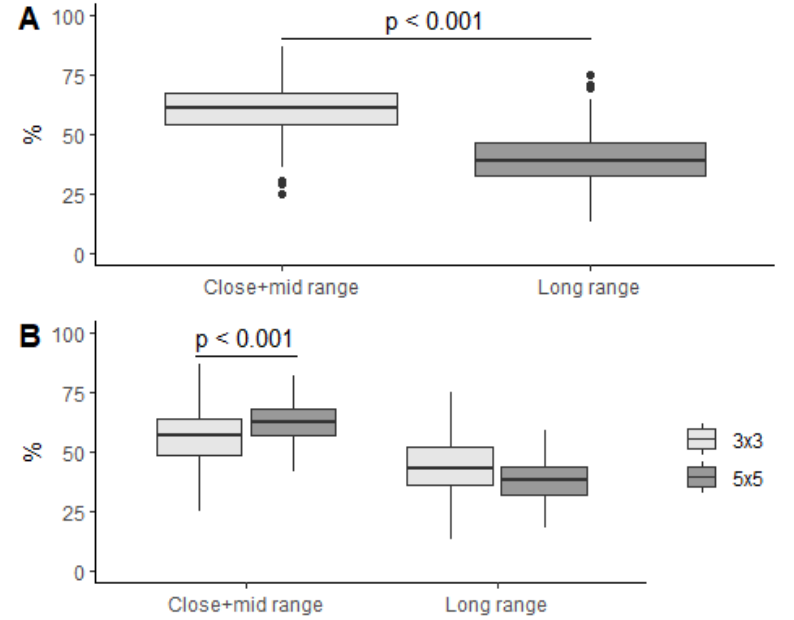
Figure 4. Ratios of close–mid- and long-range-shot attempts to all field-goal attempts overall ( A ) and regarding discipline ( B ).